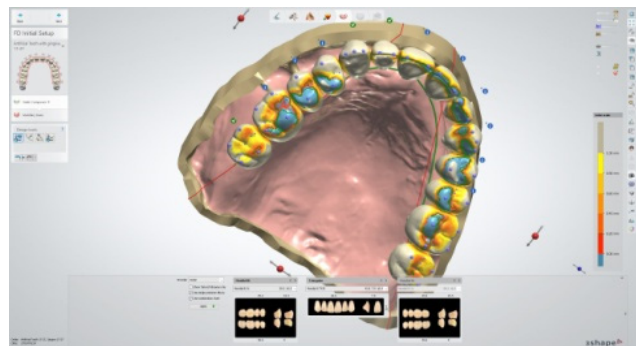
Figure 12. Customized tooth set-up with individual corrections in size, shape and position. The intensity of the occlusal contacts and the relationship of the cusps with the occlusal plane were noted in color. Blue contacts indicated teeth that needed to be moved upward in relation to the occlusal plane or a required virtual selective grinding.